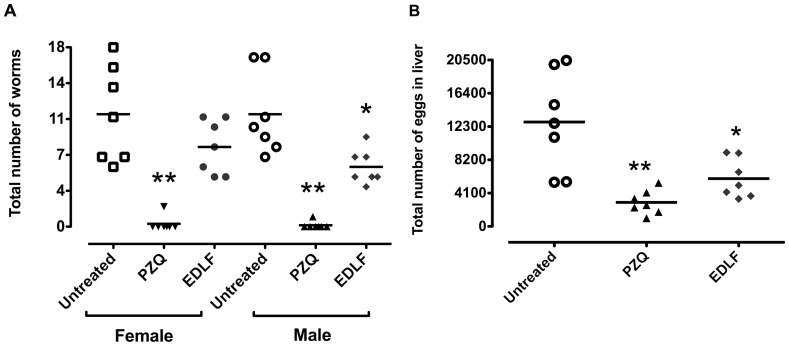
Effect on adult worm and egg burdens after treatment of S. mansoni-infected mice with praziquantel (PZQ) or edelfosine (EDLF).(A) male and female worm burdens. (B) egg burden in liver. Infected mice were treated with 500 mg/kg (x2) PZQ or 45 mg/kg (x10) EDLF. Each point represents data from an individual mouse. Horizontal bars indicate average values. (*) P<0.05. (**) P<0.01.